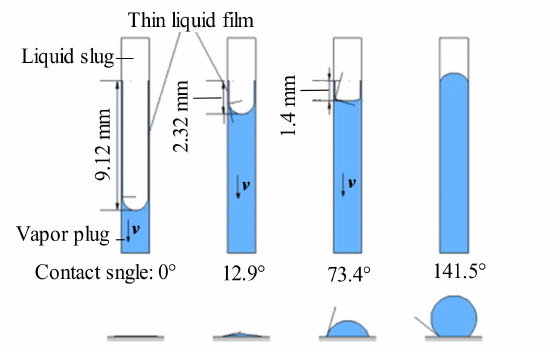
Figure 9. Schematic of the liquid–gas interface in super-hydrophilic, hydrophilic, copper, and hydrophobic OHPs [153]. Hao et al.,